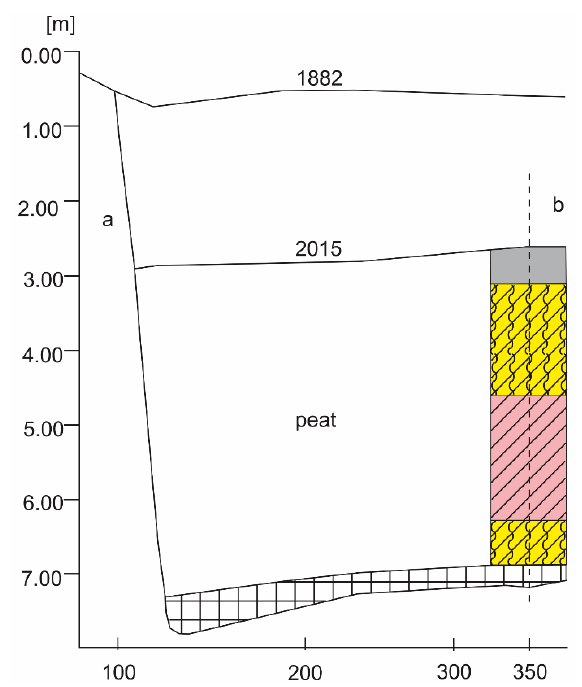
Figure 4. Historic height levels and peat coring along Transect a–b in the Dublany peatland. Legend as for Figure 3.